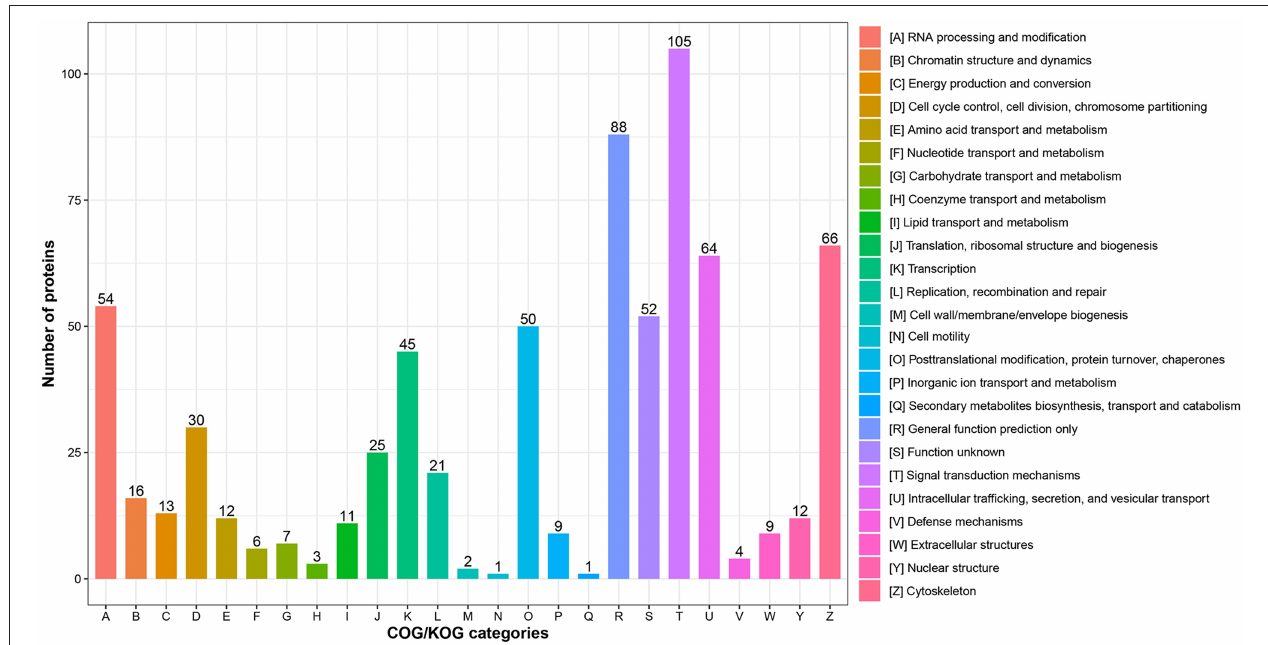
FIGURE 3 | COG/KOG functional classification analysis of differentially expressed proteins (DEPs). The DEPs were aligned to COG/KOG database and classified into 20 functional clusters. Each bar represents the number of DEPs.